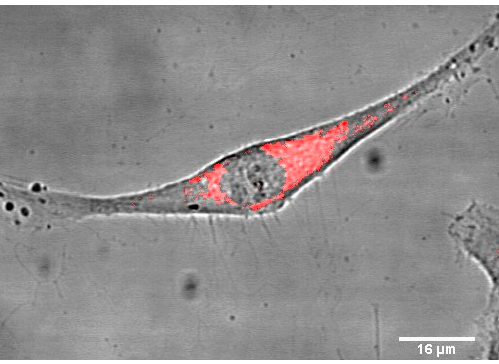
Figure 6. Confocal microscopy image of a glioblastoma cell (U87 MG) after 6 h of incubation with Au@DTDTPA-Cy5 nanoparticles (red), [Au] incubation = 5 × 10 − 4 mol. L − 1 .